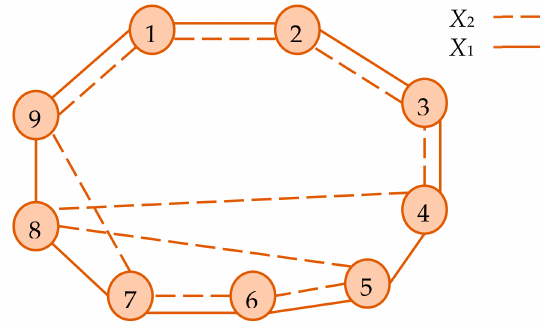
Figure 2. The routes of X 1 and X 2.